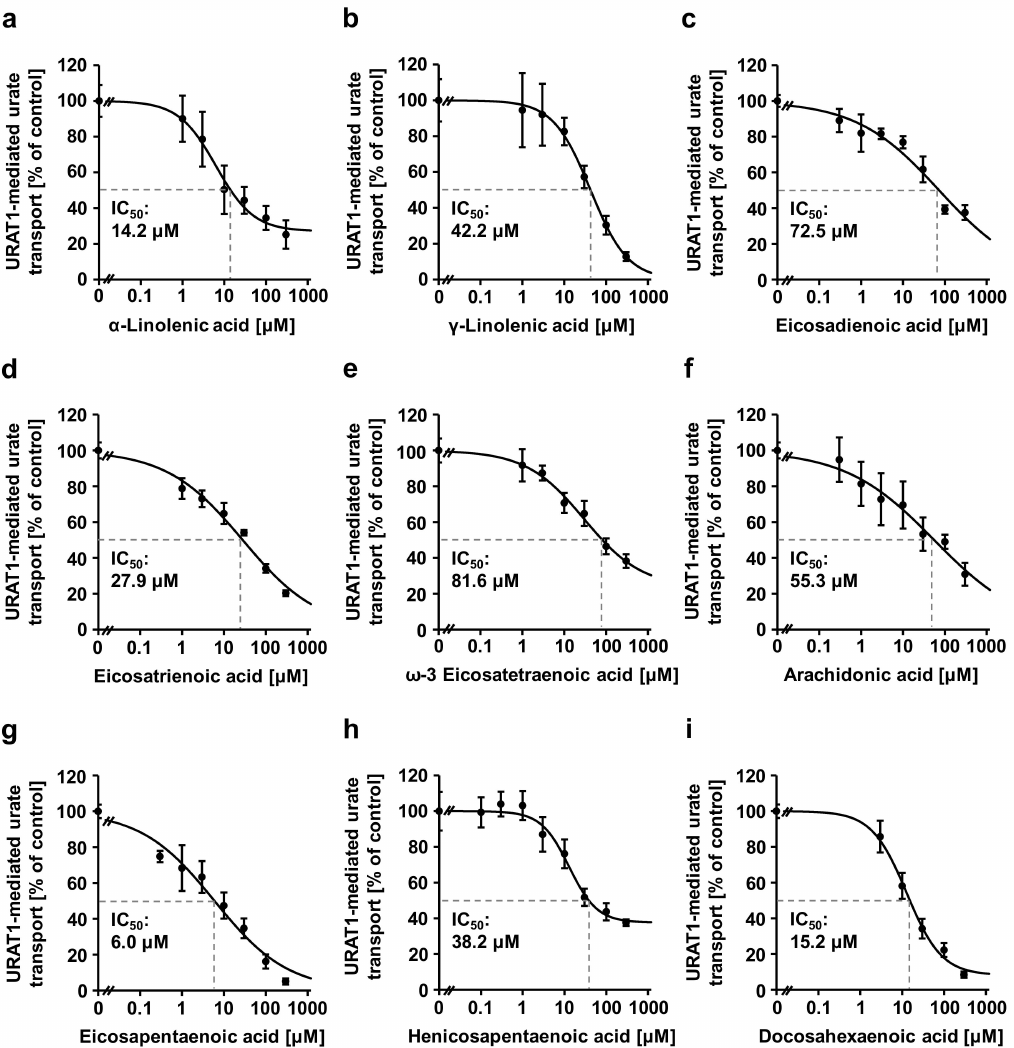
Figure 3. Concentration-dependent inhibition of URAT1-mediated urate transport by unsaturated fatty acids. The e ff ects of each unsaturated fatty acid (0, 0.1, 0.3, 1, 3, 10, 30, 100, or 300 µ M) on URAT1-mediated urate transport were investigated with the urate uptake assay. ( a ) α -Linolenic acid (ALA); ( b ) γ -linolenic acid; ( c ) eicosadienoic acid; ( d ) eicosatrienoic acid; ( e ) ω -3 eicosatetraenoic acid; ( f ) arachidonic acid ( ω -6 eicosatetraenoic acid); ( g ) eicosapentaenoic acid (EPA); ( h ) henicosapentaenoic acid; ( i ) docosahexaenoic acid (DHA). Data are expressed as the mean ± SD; n =